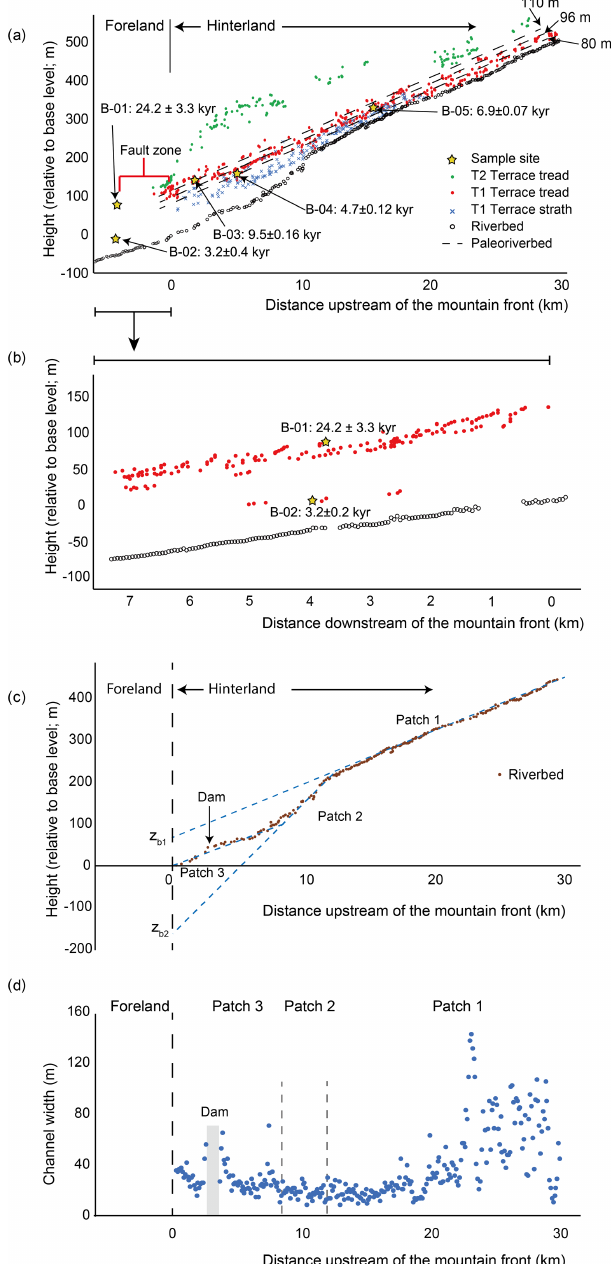
Figure 3. (a) Longitudinal profile of the Beida River channel, with terrace treads (T2, T1, and all T1 inset terrace treads) and strath elevations; sample sites and ages (expressed at the 2 σ confidence level) also indicated. Dashed lines are inferred prior river profiles corresponding to the sample site elevations, with the relative height above present base level annotated (not corrected for tectonic uplift). (b) Terrace elevations (red) and channel elevations (open circles) along the Beida River within the foreland basin. Note sparse terrace record below T1 and T1’. (c) Three patches of Beida river profile, projected to effective base level at the mountain front. (d) Present bedrock channel width measured at 100m intervals along the course of the Beida River. The width measurements that are within ∼ 500m upstream and downstream of the dam are